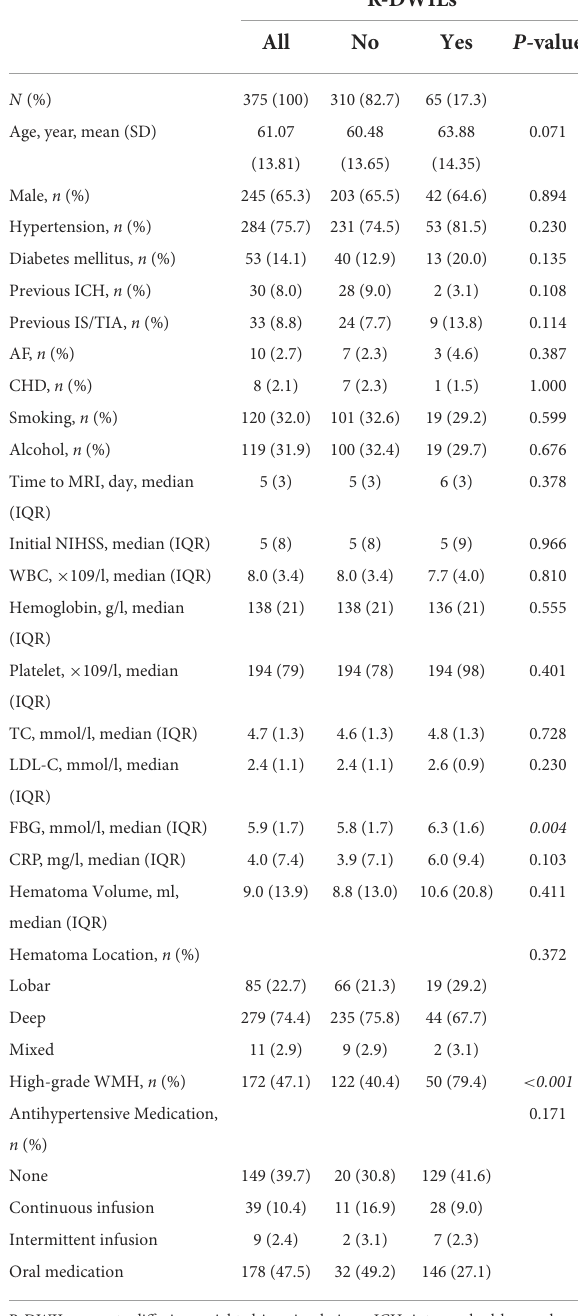
TABLE 1 Comparison of baseline characteristics between patients with and without